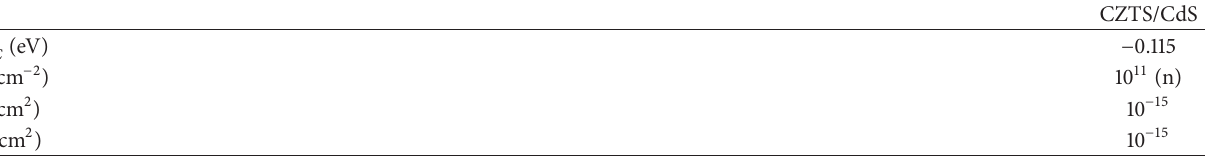
(ZnO:Al) layers are used as transparent conductive oxide and are covered with an antireflection layer (MgF 2